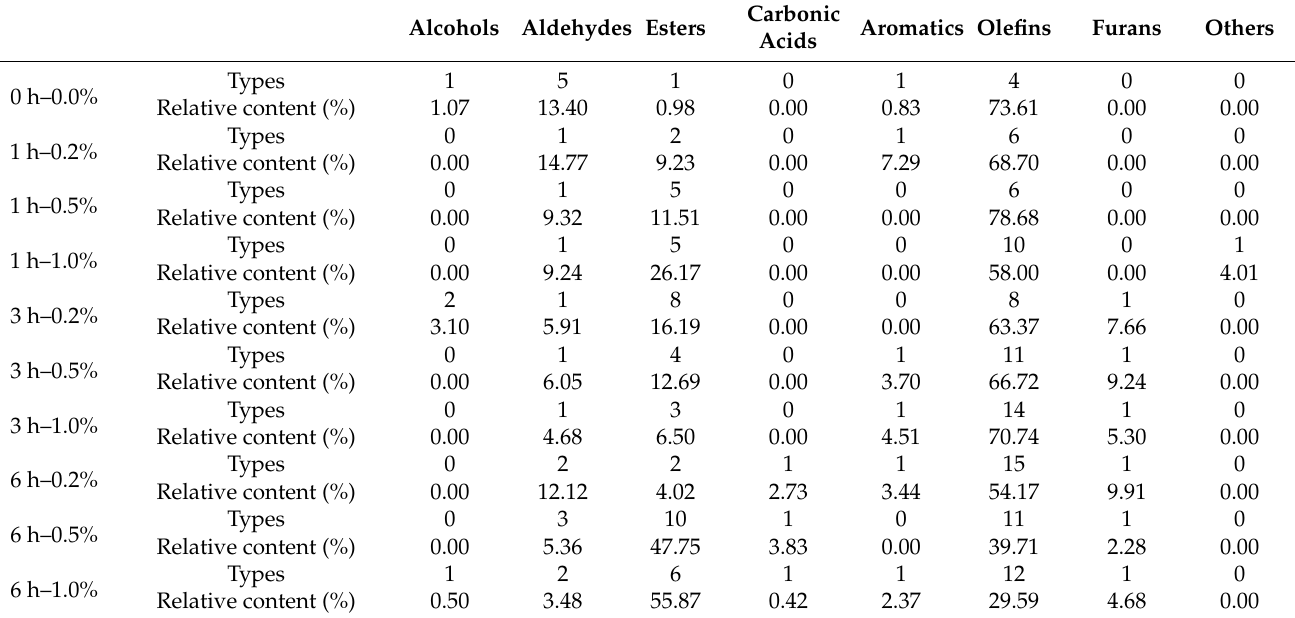
Table 2. Volatile compounds and relative contents of dried noodles under different fermentation times and yeast